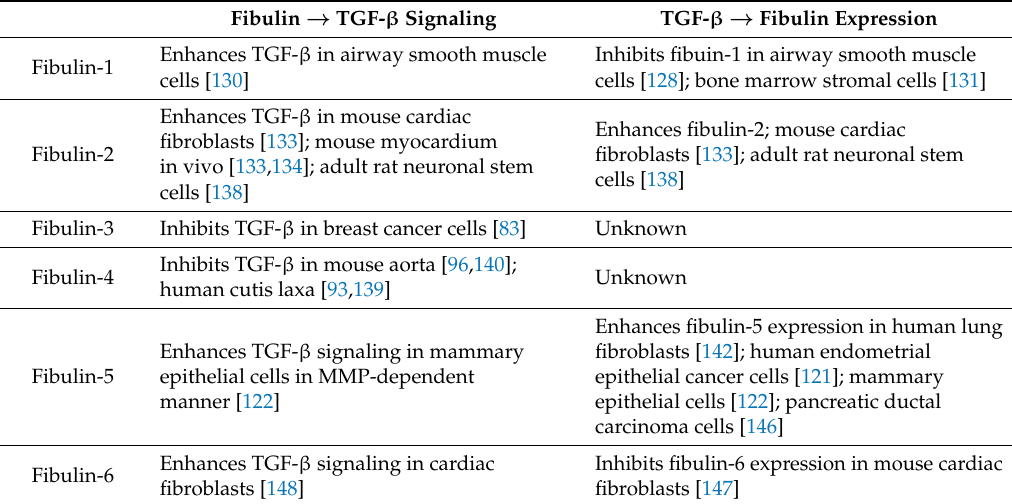
Table 1. Bidirectional Interactions between Fibulins and TGF- β